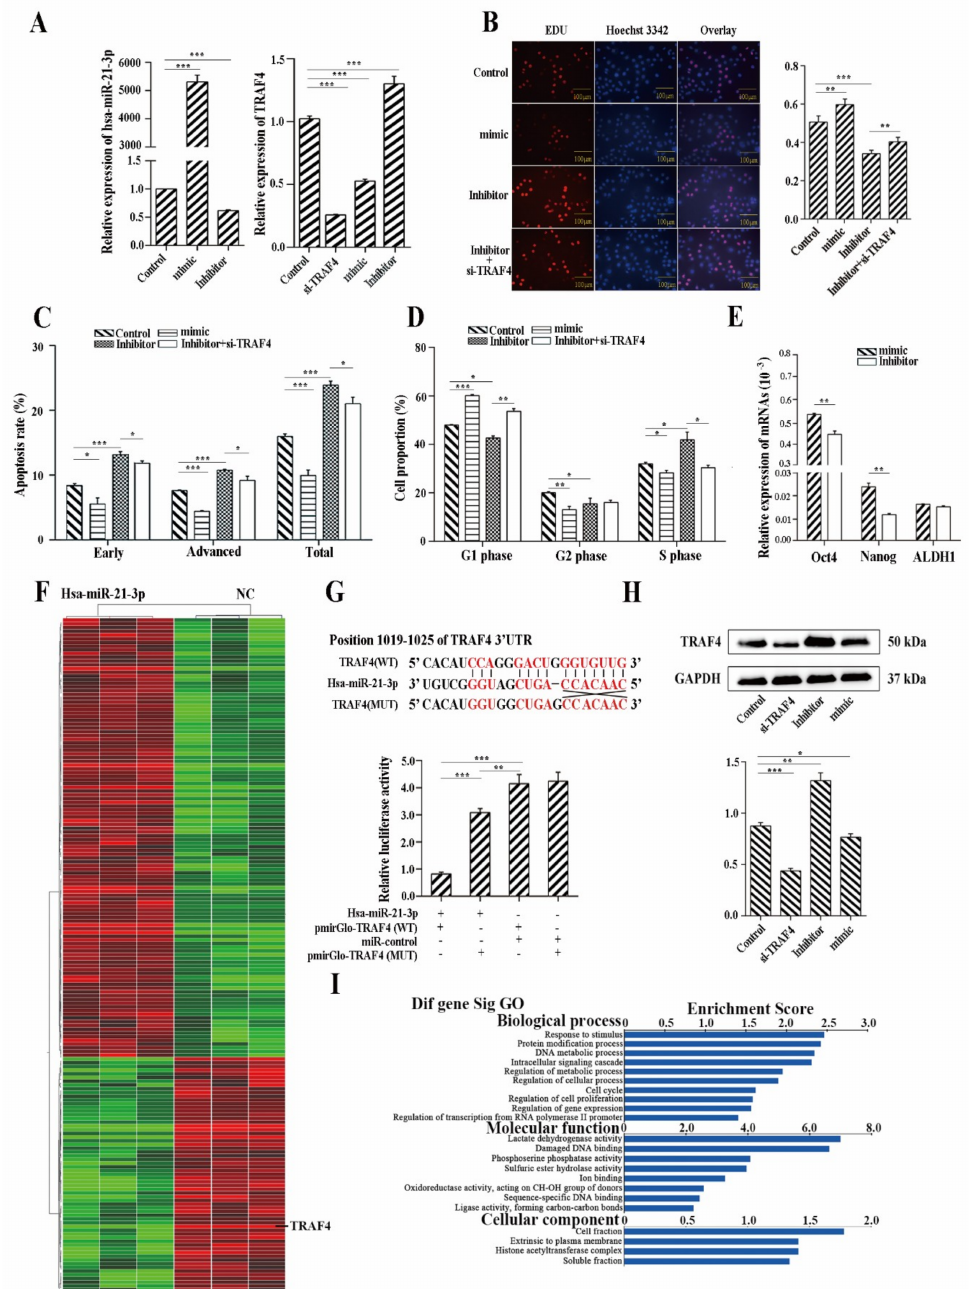
Figure 6. Hsa-miR-21-3p is critical for stemness maintenance of CSCs via inhibition of TRAF4. ( A ) Relative expression of hsa-miR-21-3p and TRAF4 detected by RT-QPCR. ( B ) Result of cell proliferation detected by EdU. Scale Bar: 100 µ m. ( C ) Result of apoptosis detected by flow cytometry. ( D )Resultofcellcycle. ( E )Expressionofstemness-relatedgenes. ( F )Clusteranalysisbasedonexpression levels of mRNAs between cells over-expressing hsa-miR-21-3p and controls. ( G ) Dual-Luciferase Reporter gene assay showed TRAF4 mRNA is a direct target of miR-21-3p. ( H ) Western blot analysis of TRAF4. ( I ) GO analysis of di ff erently expressed mRNAs. Detailed data are listed in Table S3. t -Tests (independent samples) were used to compare the result between two groups: *, p < 0.05; **, p < 0.01; and ***, p <